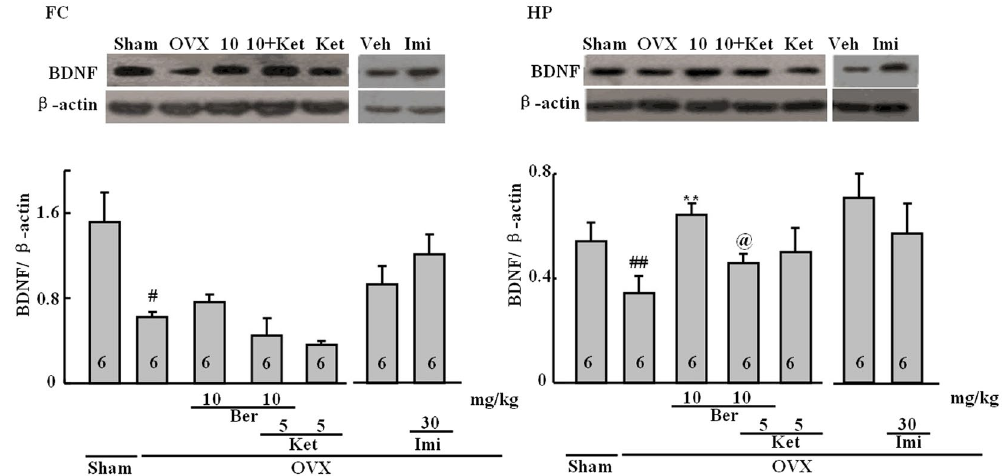
Figure 5. Representative western blots for BDNF and β -actin. The frontal cortex (FC; left) and the hippocampus (HP; right). Figures represent the BDNF levels (normalized to β -actin) in the FC and HP. Group conditions are indicated by abbreviations and doses by numbers: sham (sham treatment), OVX (ovariectomy), Ber (berberine, 5 or 10 mg/kg), Ket (ketanserin, 5 mg/kg) and Imi (imipramine, 30 mg/kg). Symbols represent significant post hoc comparisons: Tukey’s HSD, # P < 0.05 vs. sham, ** P < 0.05 versus OVX only.